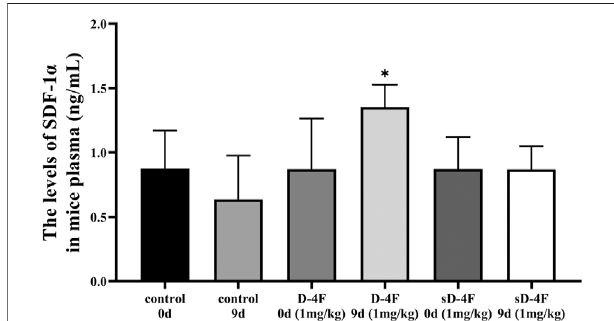
FIGURE 1 | D-4F upregulates the protein levels of SDF-1 α in mice plasma. Peripheral blood was collected before and after intraperitoneal injection of D-4F (1 mg/kg/day) or sD-4F (1 mg/kg/day) or equal volume of SPSS for 9 days, n (cid:1) 6, one-way ANOVA, SNK test, * p < 0.05, compared with other